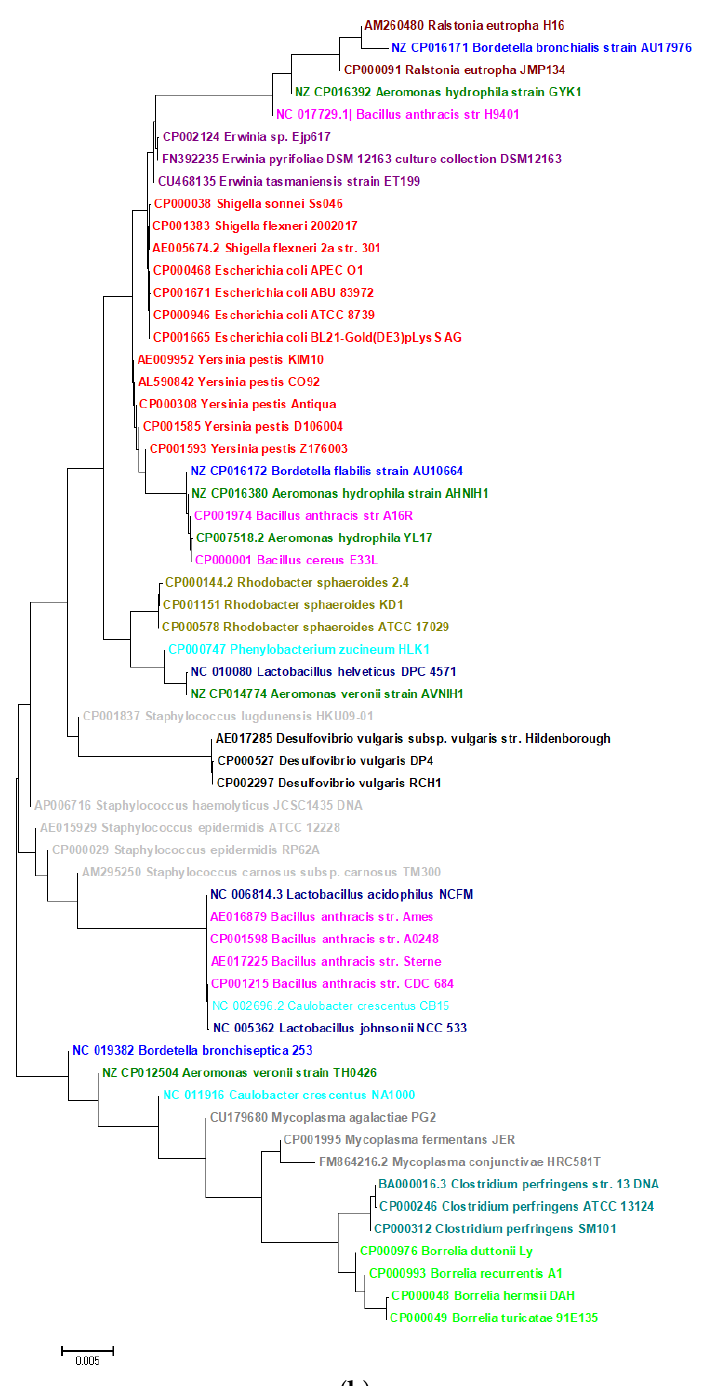
Figure 5. ( a ) The Neighbor-Joining phylogenetic tree of 59 bacteria genome sequences based on PCNV method. ( b ) The Neighbor-Joining phylogenetic tree of 59 bacteria genome sequences based on FFP method (k =